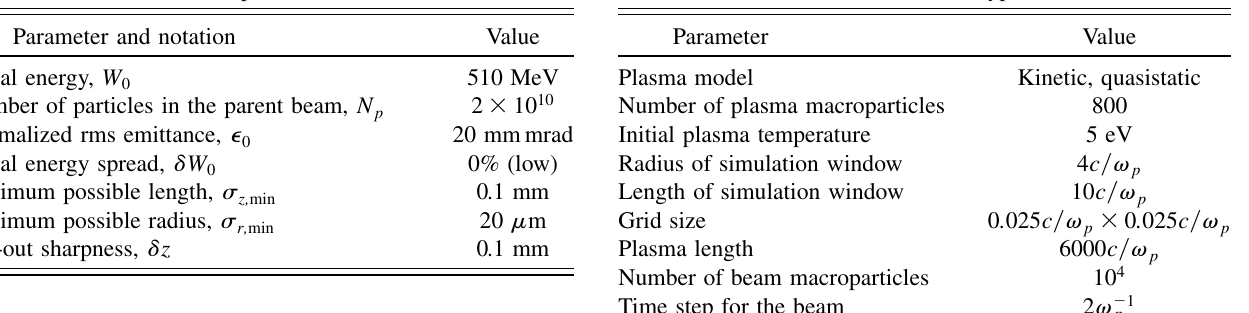
TABLE I. Fixed parameters of the